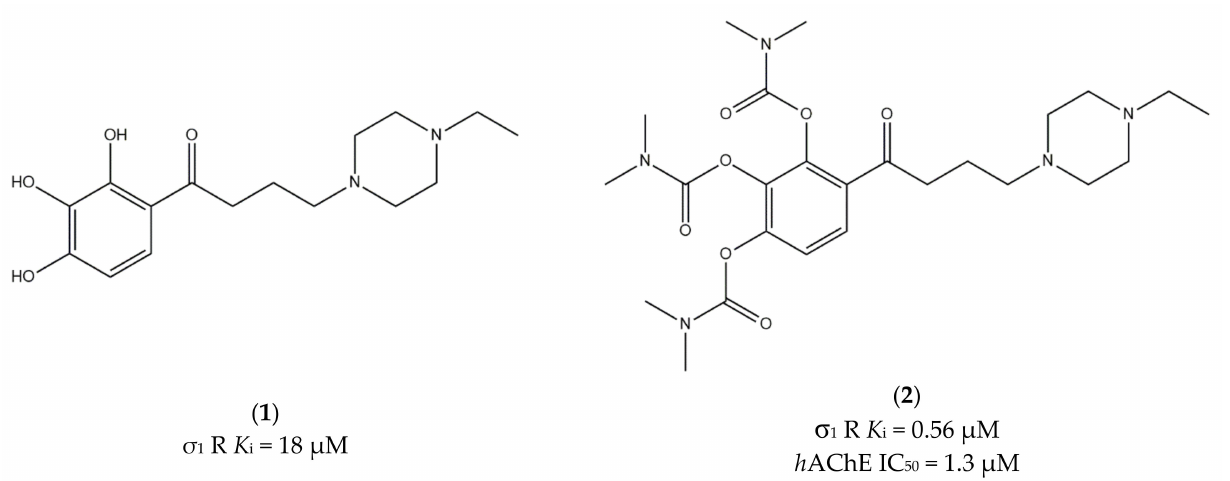
Figure 1. Compound ( 1 ) and ( 2 ) and their K i and IC 50 values for σ 1 receptor ( σ 1 R) and human acetylcholinesterase ( h AChE)